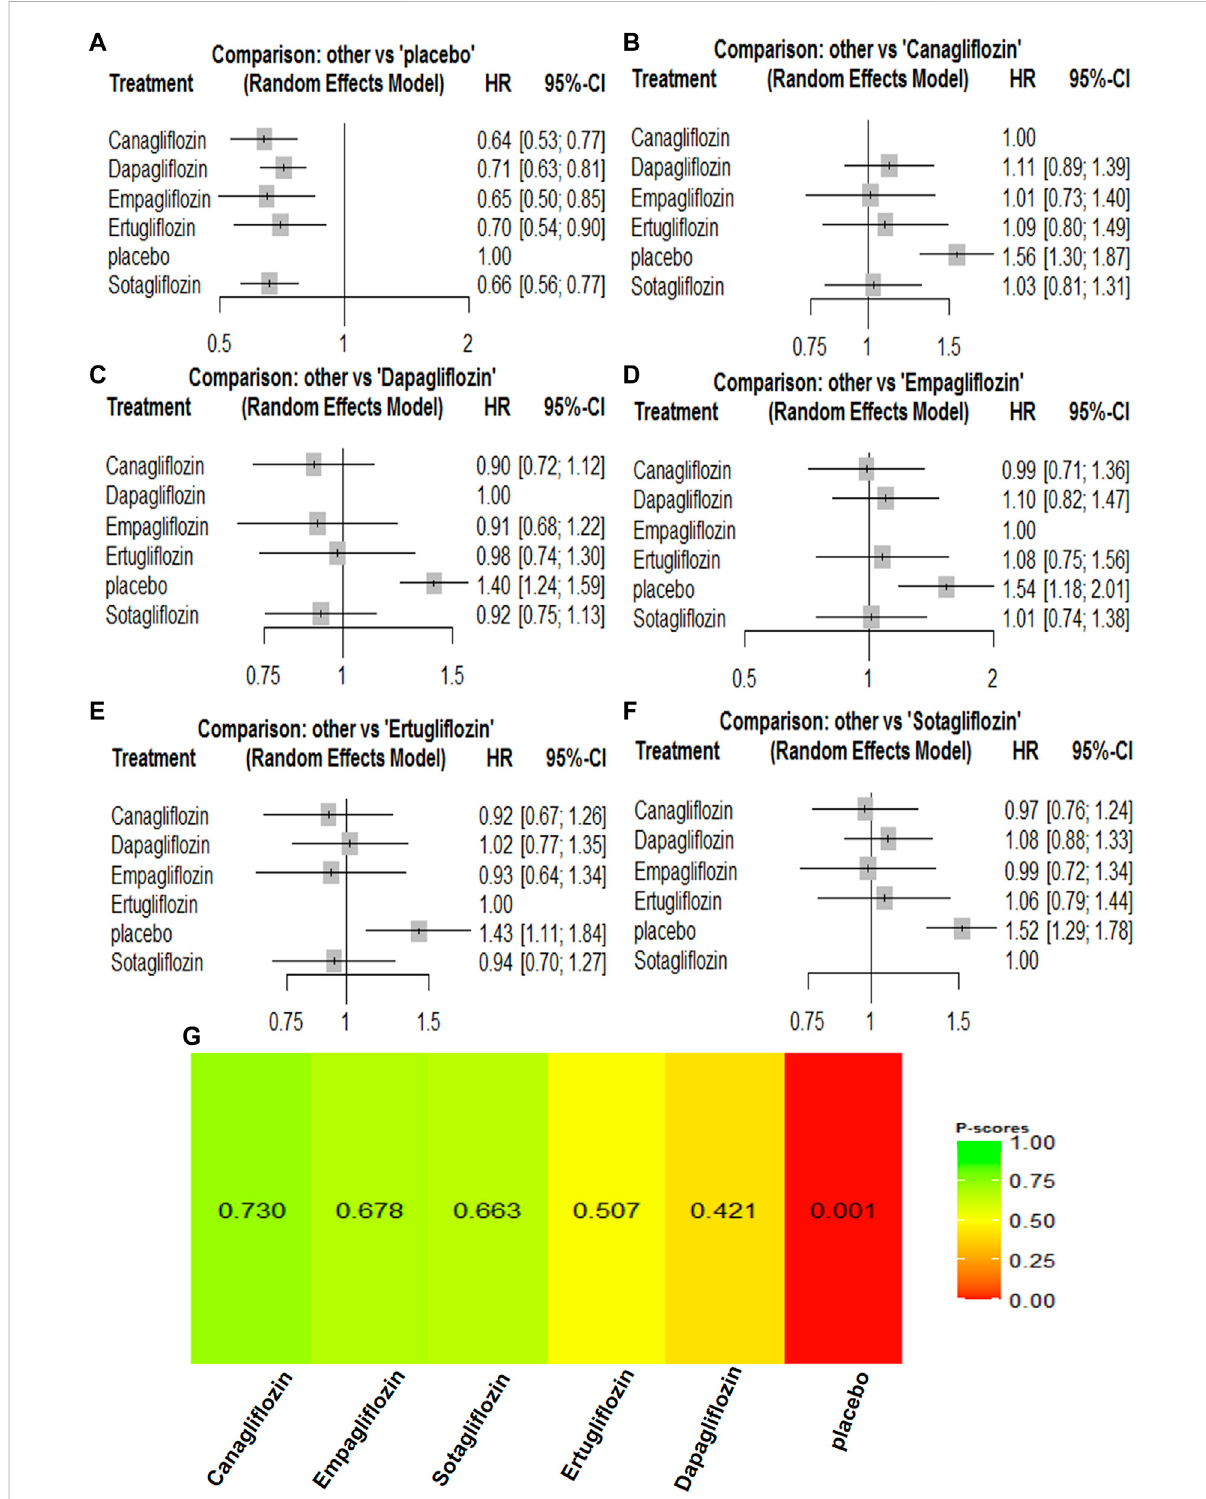
FIGURE 4 Forest PlotsandRankingPlotsofNetworkMeta-analysis ofall trialsforHospitalizationforHeart Failure. (A) Forest Plotsofotherdrugs compare tocanagli fl ozin. (B) ForestPlotsofotherdrugscomparetodapagli fl ozin. (C) ForestPlotsofotherdrugs compare toempagli fl ozin. (D) ForestPlotsof other drugs compare to ertugli fl ozin. (E) Forest Plots of other drugs compare to placebo. (F) Forest Plots of other drugs compare to sotagli fl ozin. All effectestimatesareexpressedashazardratios(HRs)fortreatmentvsthecomparatorand95%credibleintervals(95%-CI).Forexample,theHRs inhospitalizationforheartfailureforcanagli fl ozincomparedtoplacebois0.64(95%-CI0.53to0.77).Thex-axisscaleindicatestherangeoftheHRs. (G) Ranking Plots of Network Meta-analysis. Plots below the forest plots show for the rank of each drug class and ranking descending from left to right, The p-score represents the power of the